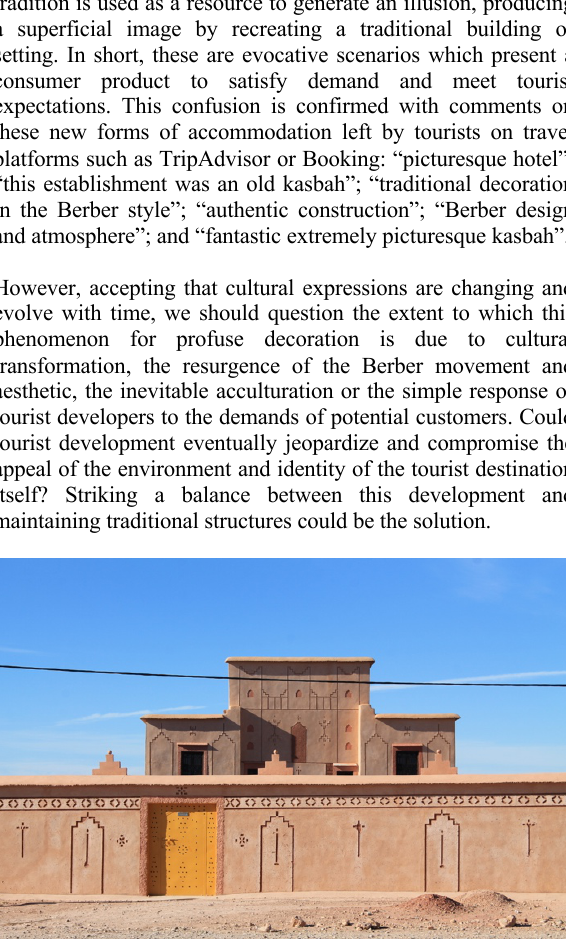
Figure 21. Contemporary dwelling in Aït Khyar,